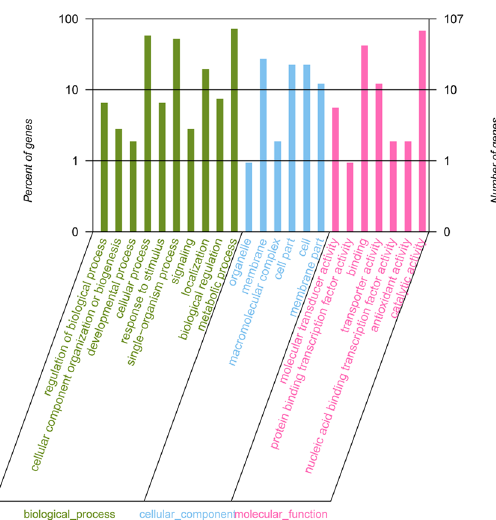
Figure 6. Functional categories of the regulated genes, broadly separated into ‘biological process’, ‘cellular component’, and ‘molecular function’, based on Gene